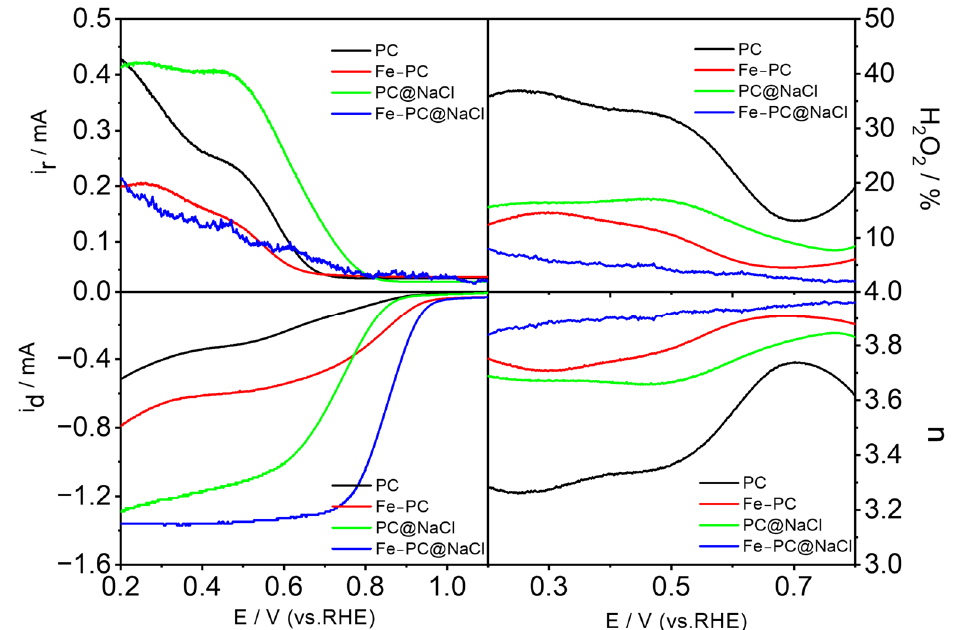
Figure 8. The LSV curve of the catalyst was obtained at 1600 rpm on the RRDE, and the corresponding electron transfer (n) and peroxide species produced (H 2 O 2 − ) in the ORR process.